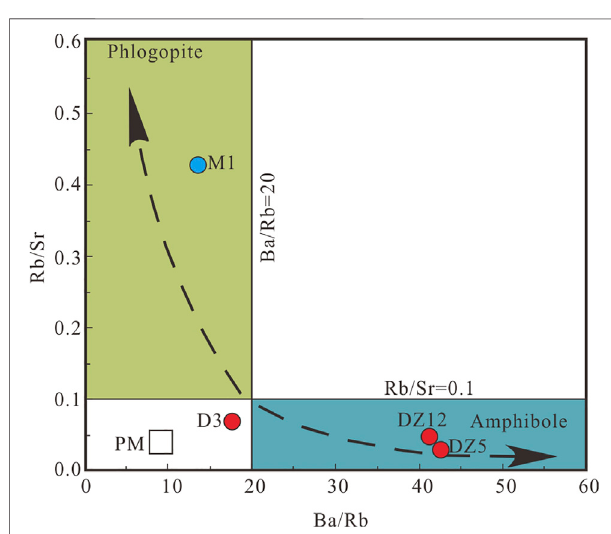
FIGURE 9 | Rb/Sr vs. Ba/Rb diagram (see e.g., Furman and Graham, 1999).